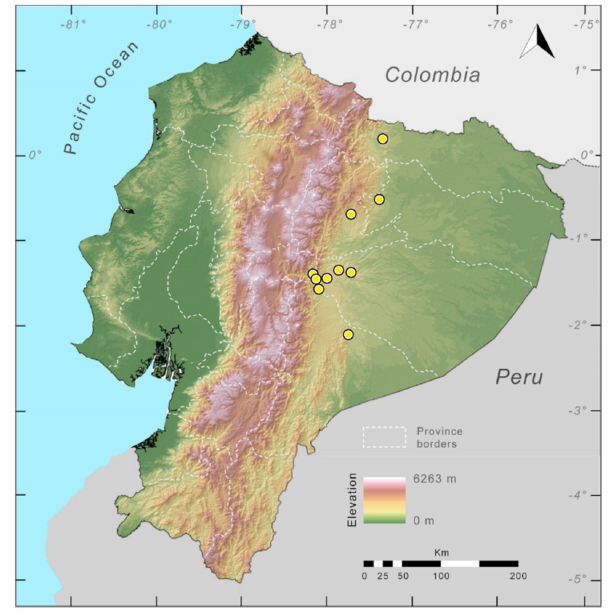
Figure 194. Distribution of Rulyrana flavopunctata in Ecuador (yellow